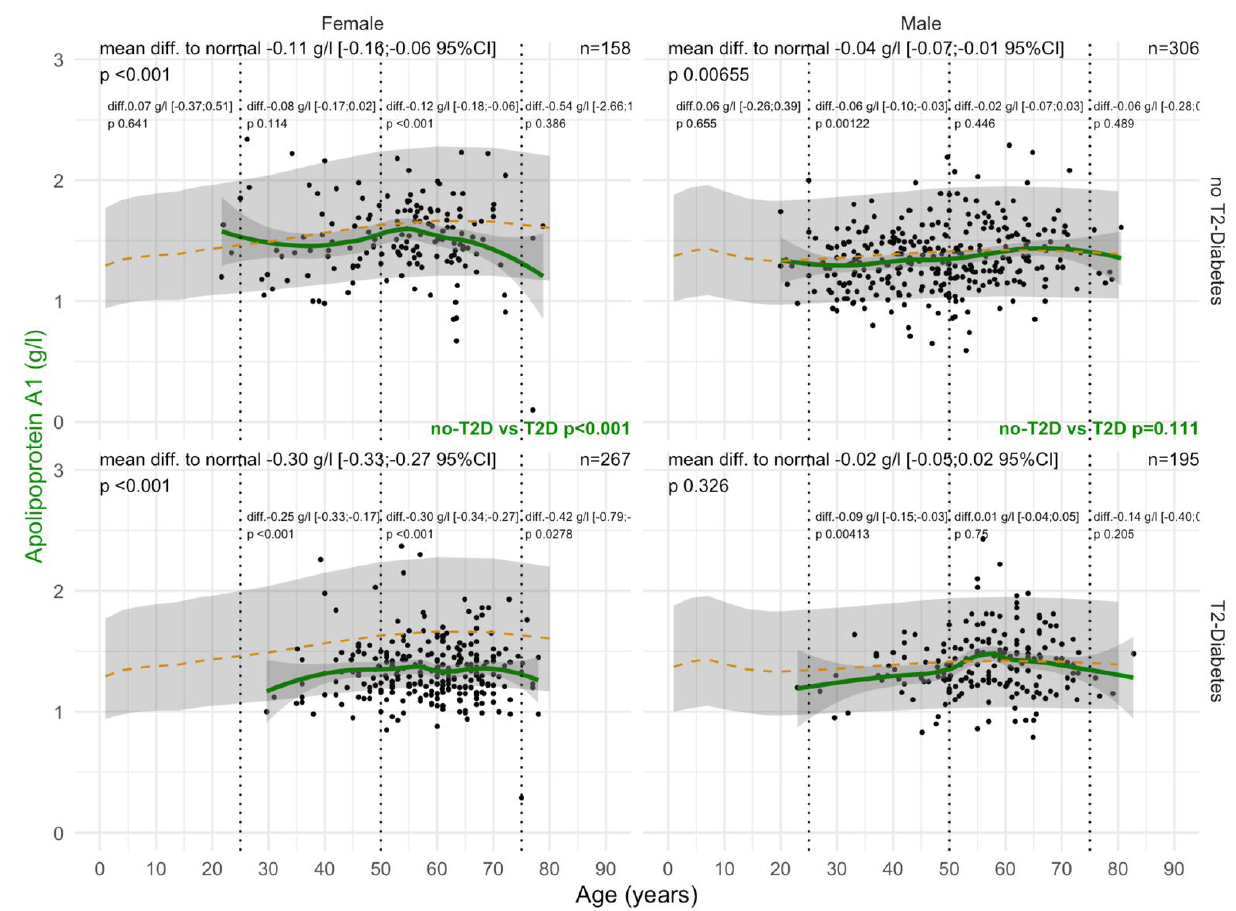
Figure 5. ApoA1 levels in all “ NAFLD-Biopsy ” patients. Impact of T2DM on ApoA1 concentration in all NAFD-biopsied patients (n = 926). Normal serum means according to age and sex (dashed – orange lines), with 95% confidence intervals (light-gray ribbon). Three vertical – dotted lines mark the four age groups (before 25, between 25 and 50, between 50 and 75, and above 75 years old). Each point is a patient ’ s protein value. The green curve is a Loess regression of the median of ApoA1 values, along with its 95% confidence interval (darker gray). For each age group, the mean difference (%95CI) between the patient protein value and the expected normal value (for age and sex) with its significance p –value is displayed at the top of the figure. The significance between the non-T2DM and T2DM patients is displayed in green between the 2 panels.